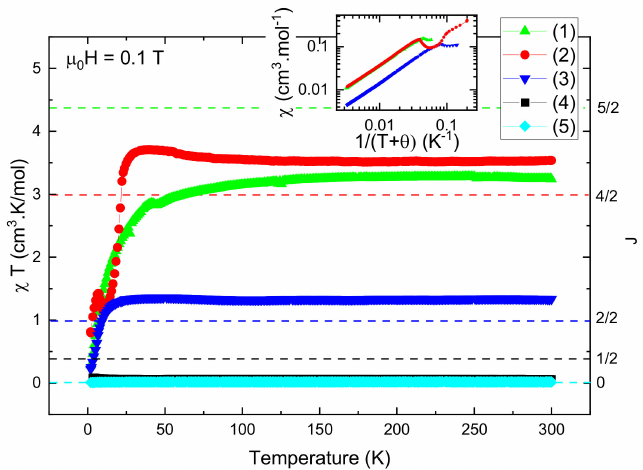
Figure 3. Reduced magnetic response χ T vs. T for all samples, measured at µ 0 H = 0.1 T. The horizontal dashed lines represent the expected behaviour for the compound of corresponding colour, had their magnetic response been solely generated by its isolated paramagnetic ion in the (II) oxidation state. The right-hand axis indicates the associated values of J . The deviation of the data towards zero, observed below 75 K, indicates antiferromagnetic interactions. The inset shows a plot of χ vs. ( T + θ ) − 1 for ( 1 ), ( 2 ) and ( 3 ). Here θ is the Curie-Weiss temperature, and equals to 15 K, 3 K and 5 K for ( 1 ), ( 2 ) and ( 3 ), respectively. In this scale, linearity denotes a Curie-Weiss behavior, whereas a deviation towards lower values at large ( T + θ ) − 1 indicates the presence of a magnetic transition towards an antiferromagnetic state at low